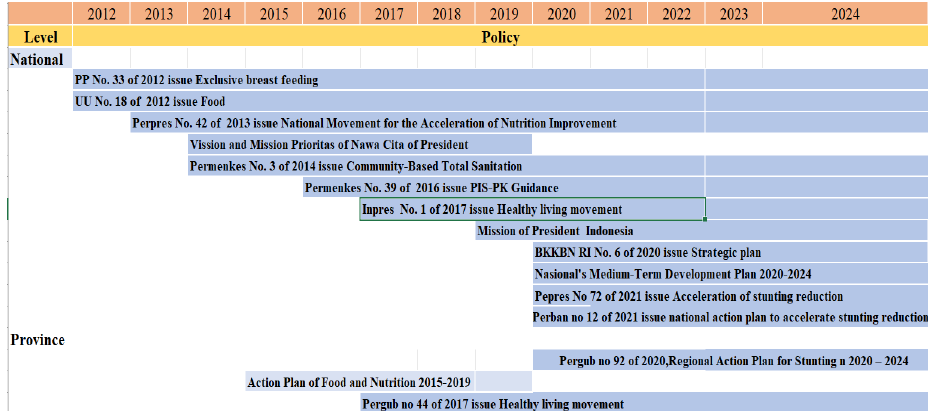
Figure 8. Overview of legislation, policies, initiatives, and enablers 2012 and 2024 in Yogyakarta Province and Indonesia.